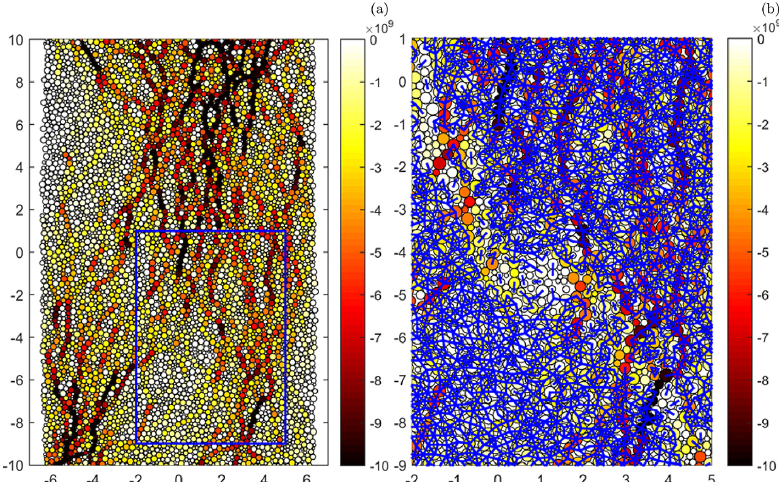
Figure 10. Instantaneous normal stress (color scale; in Pa) acting on individual grains in simulation under uniaxial compressive strain shortly after terminal failure of the material ( t = 600s; see Figs. 6 and 8). Panel (b) shows a fragment within the rectangle marked in (a) , with bonds between grains illustrated with thick blue lines. Reference model settings.